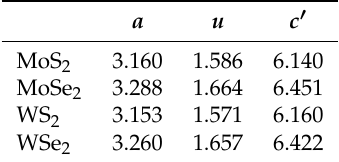
Figure 1. ( a ) Sketch of the atomic structure of MX 2 . The bulk compound has a 2H– MX 2 structure with two MX 2 layers per unit cell, each of them being built up from a trigonal prism coordination unit. The value of the lattice constants for each family is given in Table 1; ( b ) top view of monolayer MX 2 lattice. Green ( blue ) circles indicate M ( X ) atoms. The nearest neighbors ( δ i ) and the next nearest neighbors ( a i ) vector are shown in the figure. Table 1. Lattice parameters for the TMDs (transition metal dichalcogenides) considered in the text. a represents the M – M atomic distance, u the internal vertical separation between the M and the X planes, and c (cid:48) the distance between the metal M layers. In bulk systems, c = 2 c (cid:48) accounts for the z -axis lattice parameter. All values are in Å